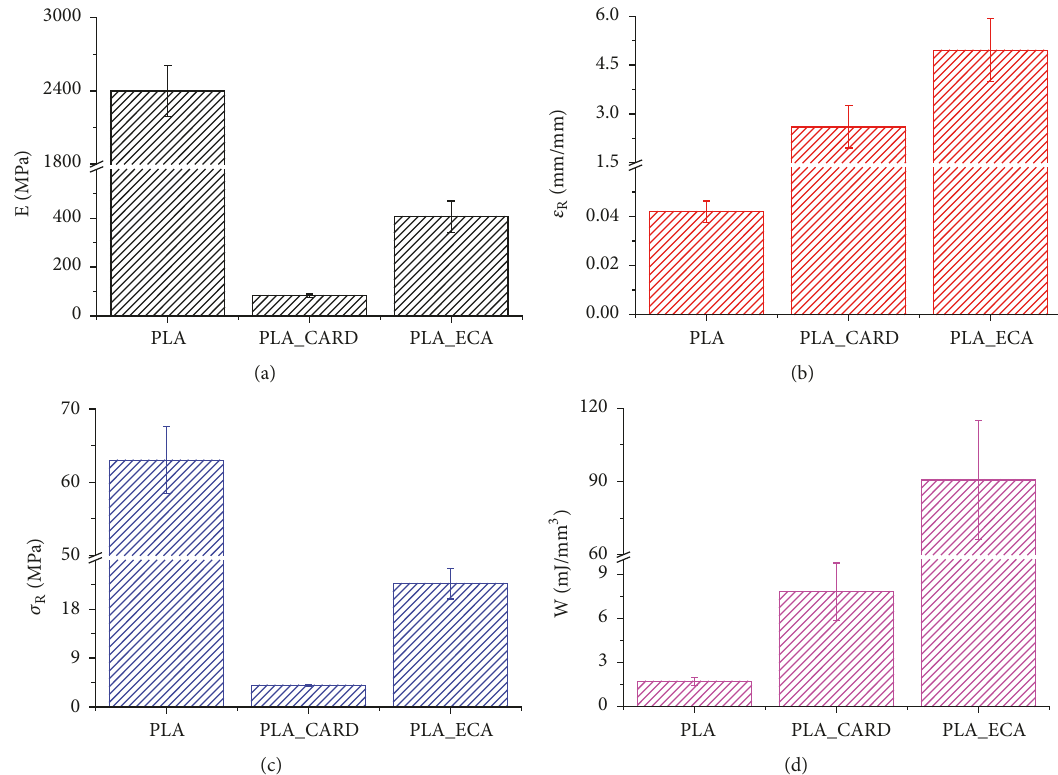
Figure 7: Mechanical properties of rotational molded plasticized PLA: (a) tensile modulus, (b) strain at break, (c) tensile strength, and (d)